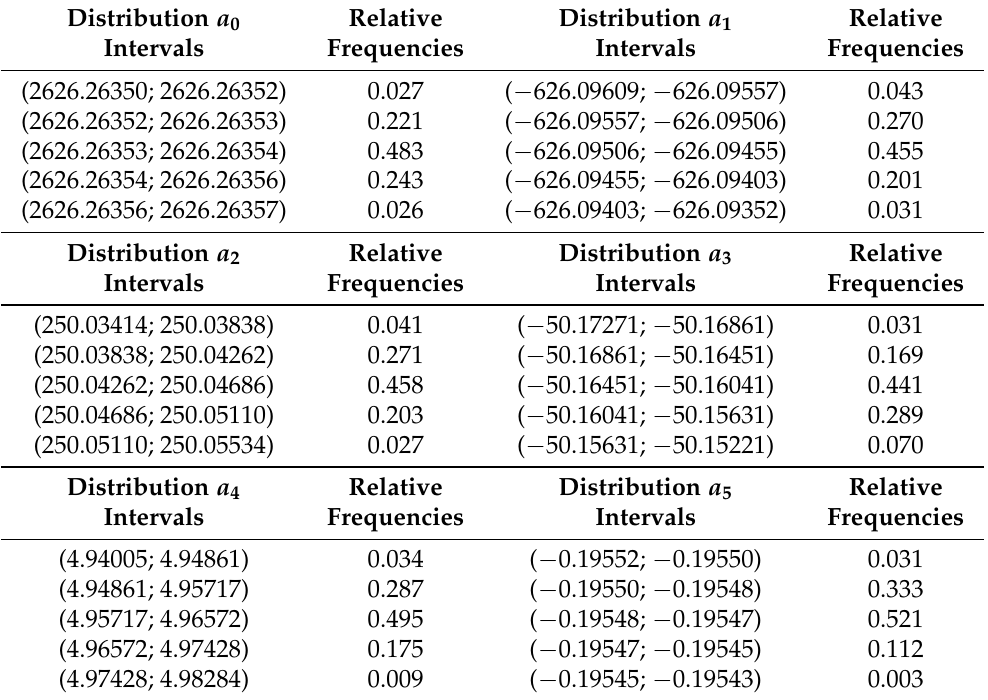
Table 2. a 0 = 2626, a 1 = − 626, a 2 = 250, a 3 = − 50, a 4 = 5, a 5 = −